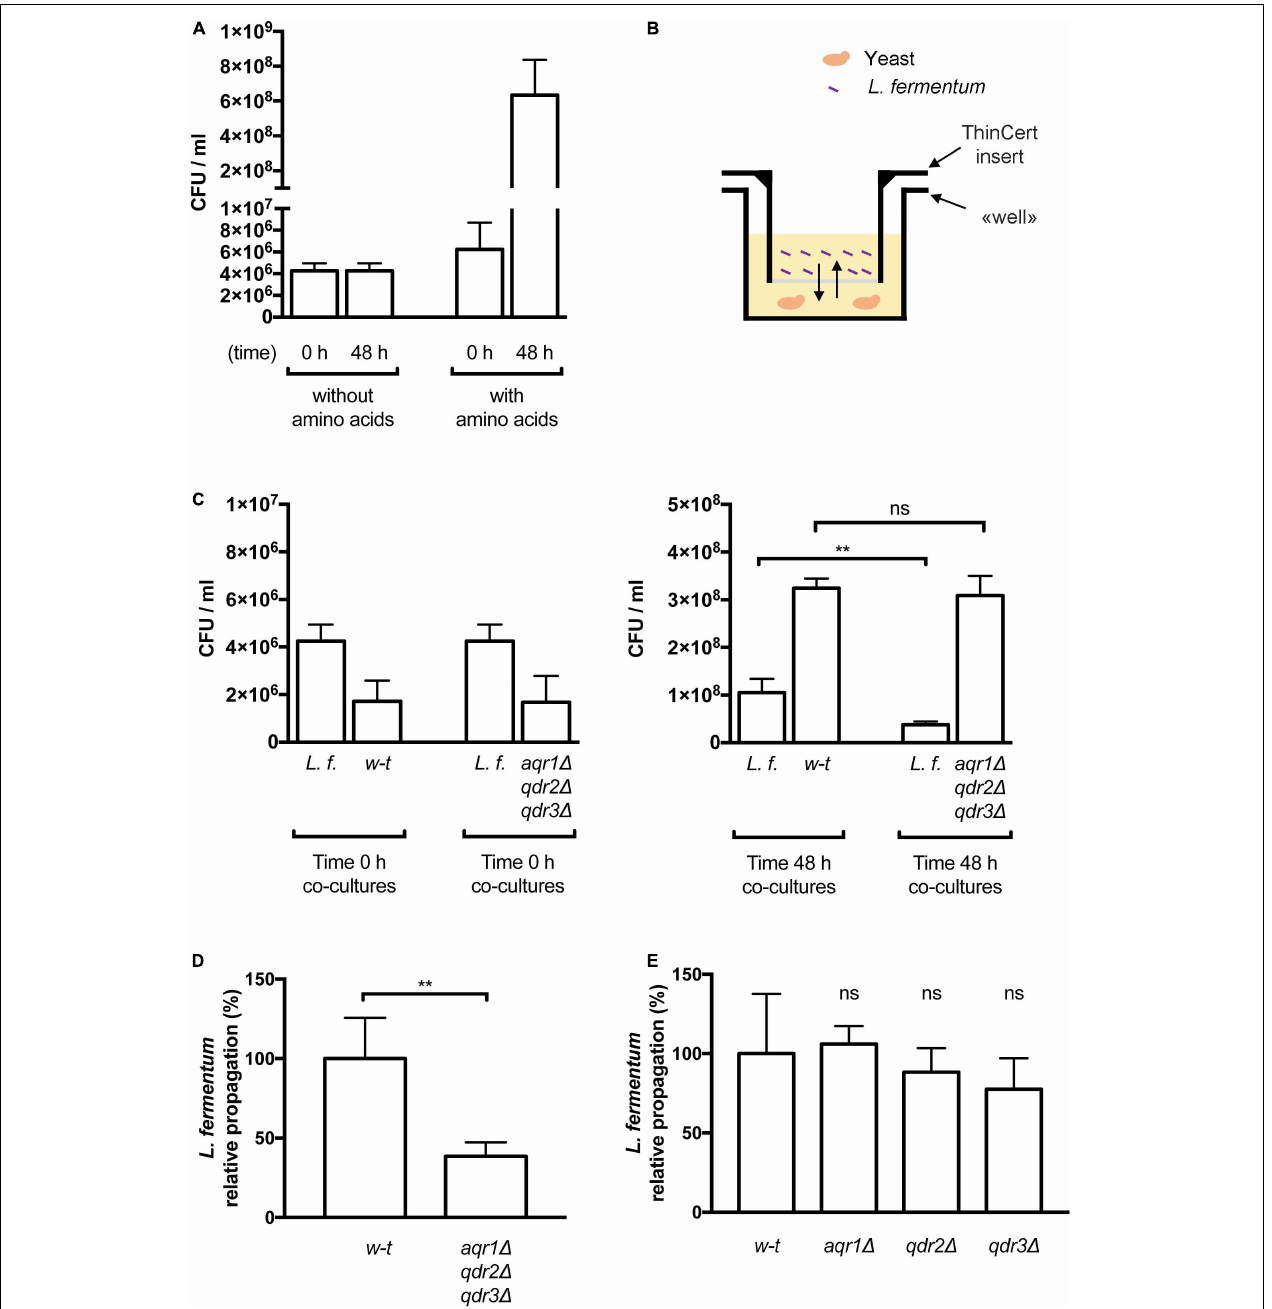
FIGURE 5 | The Aqr1, Qdr2, and Qdr3 exporters promote cross-feeding of lactic acid bacteria. (A) Amino acid supplementation is critical for Lactobacillus fermentum growth. Minimal liquid 169 medium containing amino acids or not was inoculated with L. fermentum and growth was monitored by counting colony-forming units per milliliter (CFU/ml) just after inoculation (0 h) and after 48 h of growth. Bars represent averages of four independent experiments ± standard deviation (SD). (B) Schematic representation of the co-culture system. The yeast cell suspension is placed in the well and the insert prefilled with the L. fermentum cell suspension is placed on top of it. The arrows represent diffusion of solutes across the membrane separating the two cultures. (C,D) Yeast cells lacking Aqr1, Qdr2, and Qdr3 display a reduced ability to cross-feed L. fermentum . (C) Cell densities in co-cultures of L. fermentum ( L.f. ) with the wild-type (w-t) or aqr1 (cid:49) qdr2 (cid:49) qdr3 (cid:49) mutant yeast strain were assessed by counting CFUs just after inoculation (left) and after 48 h of growth (right). (D) The values presented in (C) were used to calculate the relative propagation of L. fermentum when co-cultivated with the wild-type or the aqr1 (cid:49) qdr2 (cid:49) qdr3 (cid:49) yeast strain. Bars represent averages of four independent experiments ± standard deviation (SD). (E) Single deletion of the AQR1 , QDR2, or QDR3 gene does not significantly impair cross-feeding of L. fermentum . Experimental conditions and calculation as in C-D, except that the yeast strains contained only an aqr1 (cid:49) , qdr2 (cid:49) or qdr3 (cid:49) single mutation. Bars represent averages of four independent experiments ± standard deviation. * indicates a statistically significant difference as determined with the unpaired t- test. ** P < 0.0021. ns, not significant, P > 0.05.